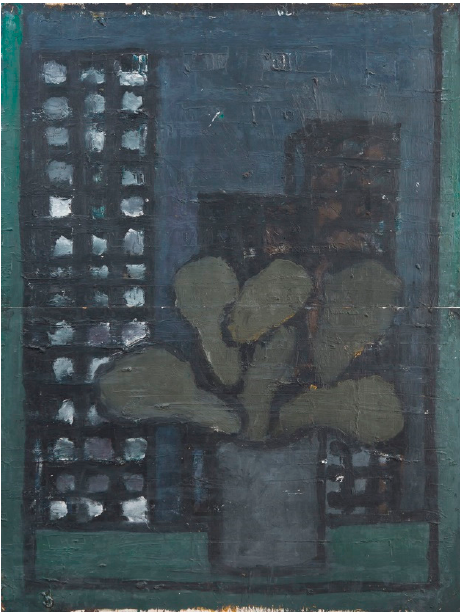
Figure 4. Asim Abu Shakra: Cactus with City in the Background . 1988. Oil on Paper (105 cm × 140 cm). Courtesy Sultan Sooud Al Qassemi.